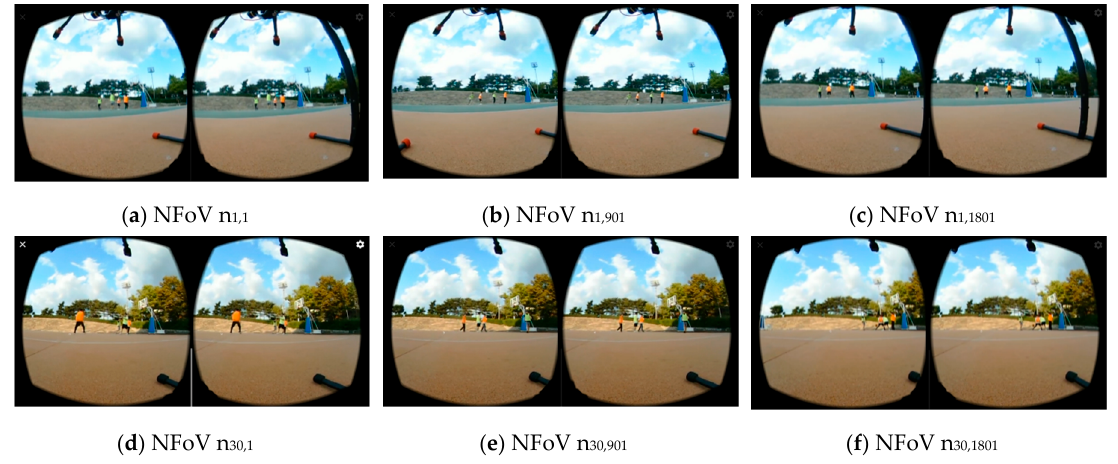
Figure 8. NFoVs calculated using the collected 360-degree video and video control signal.